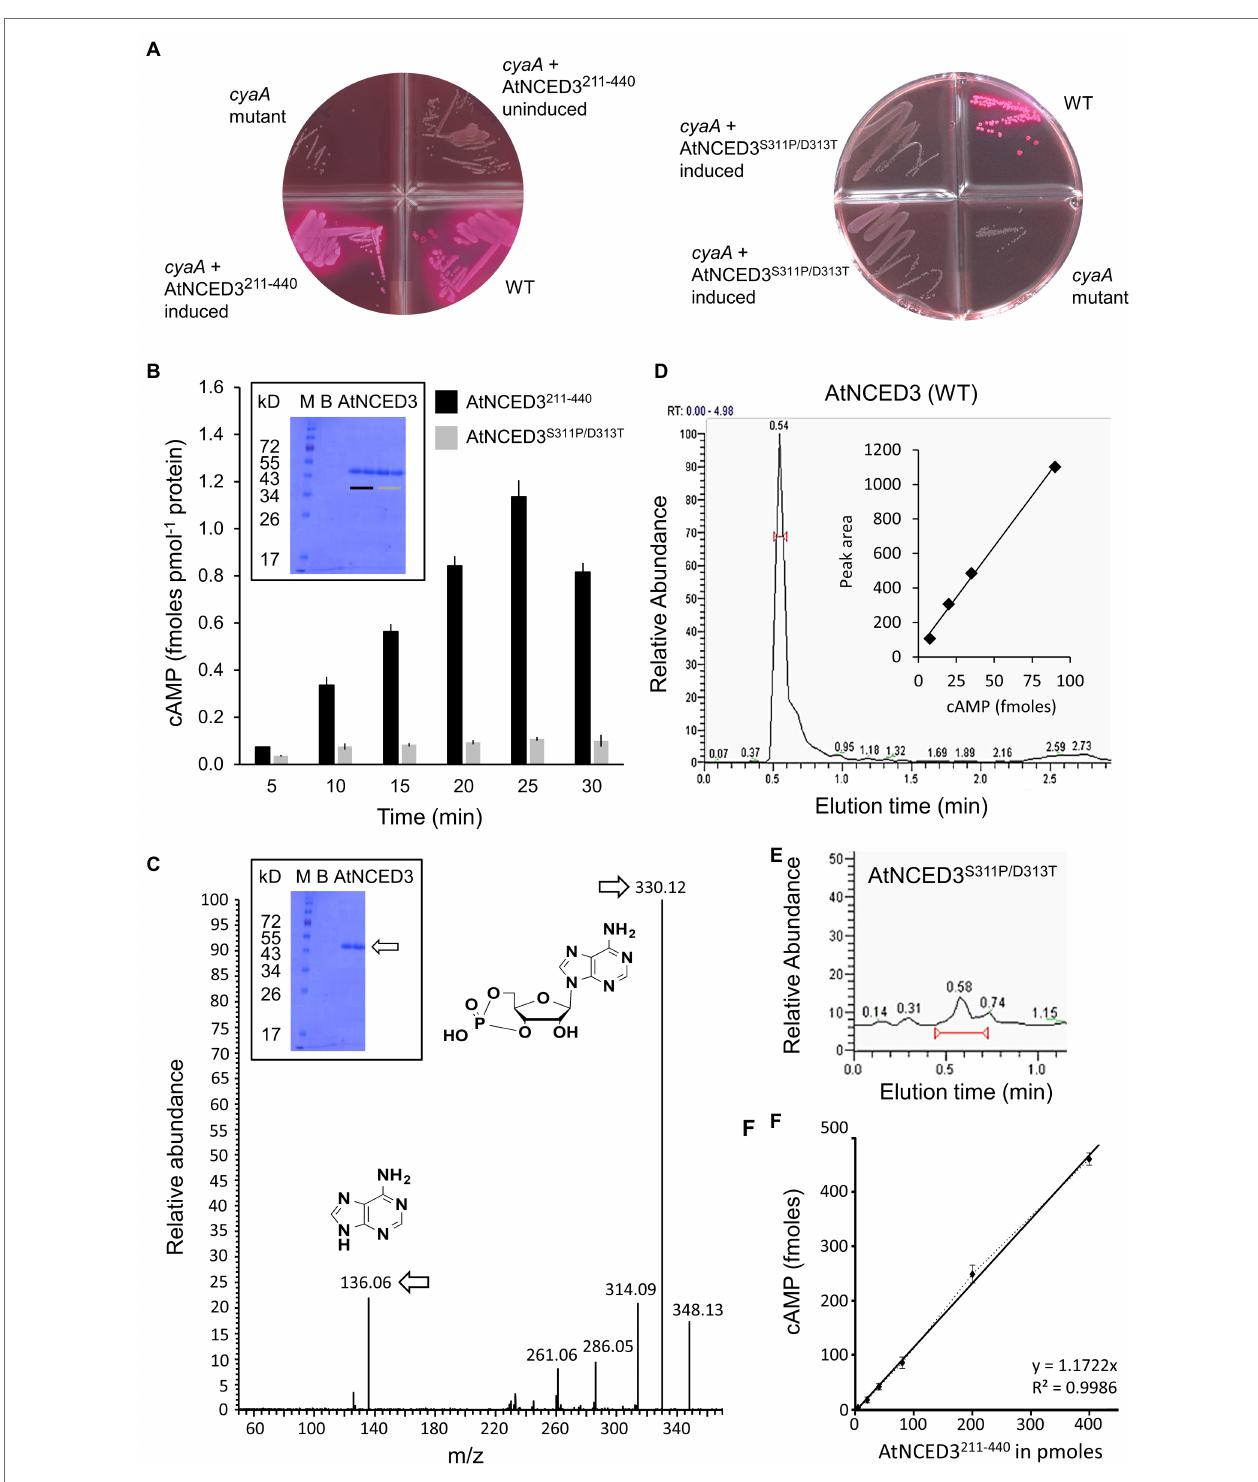
FIGURE 2 | Experimental validation of AC activity in vitro . (A) Complementation of E. coli cyaA with AtNCED3 AC fragments AtNCED3 211-440 (left) and AtNCED3 S311P/D313T (right). (B) Determination of cAMP generated by AtNCED3 211-440 and AtNCED3 S311P/D313T using enzyme-immunoassay. Reaction mixtures contain 10 μ g of AtNCED3 211-440 or AtNCED3 S311P/D313T , 50 mM Tris–HCl pH 8; 2 mM IBMX, 1 mM ATP, and 5 mM MnCl 2 . Measurements of three independent experiments are represented as mean ± SE. The inset shows an SDS-PAGE gel of the AtNCED3 211-440 (black bar) and AtNCED3 S311P/D313T (grey bar) recombinant proteins. B = blank; M = marker. (C) Mass spectrometric detection of cAMP. A representative ion chromatogram of cAMP showing the parent and daughter ion peaks